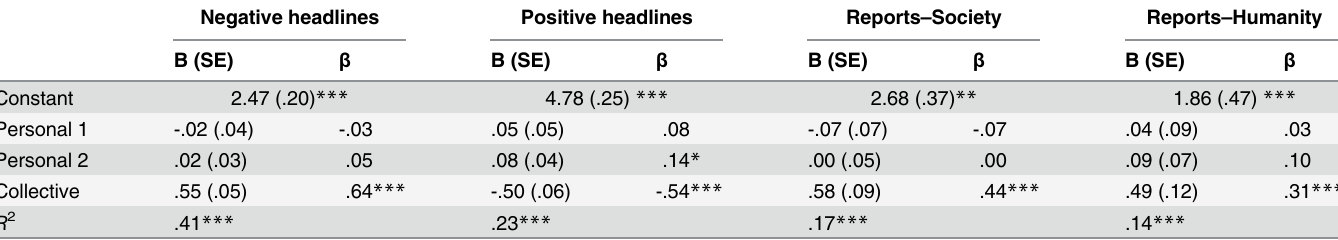
Table 3. Regression Analysis for Predictors of Negative and Positive Headlines and Attribution of Causality to Society and Humanity in Reports (Study